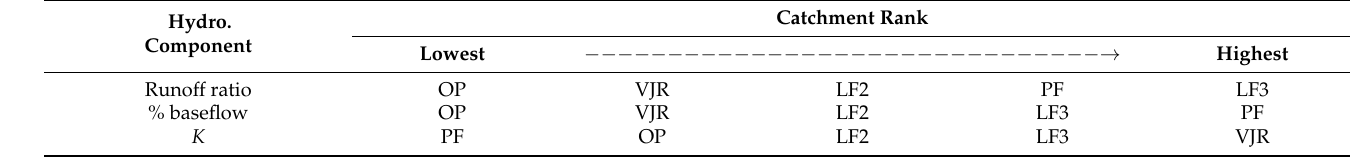
Table 6. Rank order of land-uses for various key catchment hydrological parameters. The runoff ratio and % baseflow were based on the full dataset (22 months); K was based on the recession dataset (37 recession